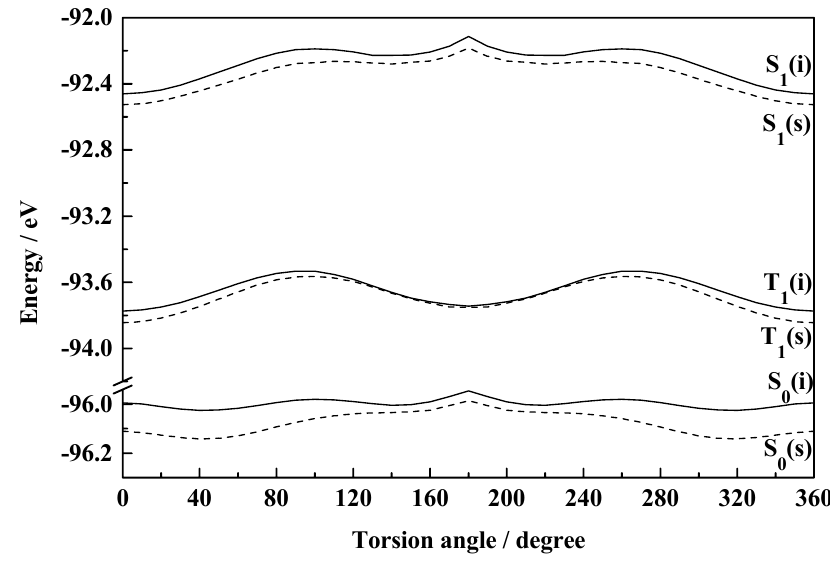
Figure 5. Plot of total molecular energy as a function of torsional angle (2-1-7-8) in S states of HPI (i, isolated; s, solvated in ethanol).